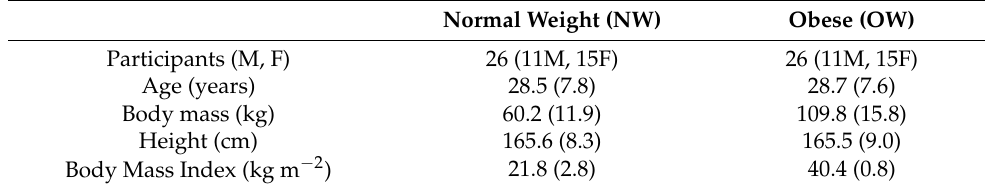
Table 1. Anthropometric and clinical features of participants. Values are expressed as mean